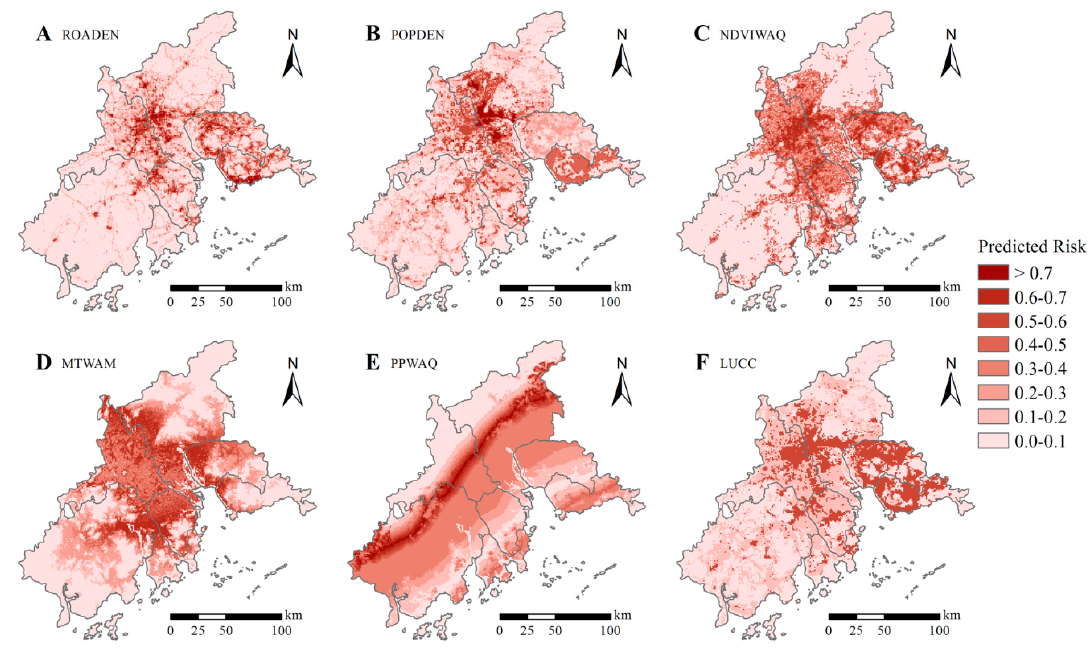
Figure 6. Spatial distribution of the variables related to predicted risk of Dengue Fever: ( A ) road density; ( B ) population density; ( C ) normalized difference vegetation index (NDVI) of the warmest quarter; ( D ) mean temperature of the warmest month; ( E ) precipitation of the warmest quarter; ( F ) land use and land cover change (LUCC).